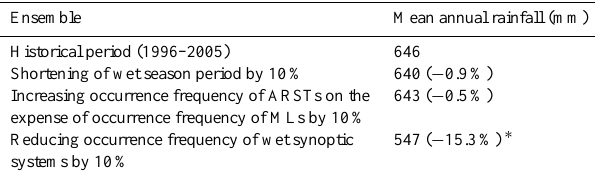
Figure 7. Same as Fig. 6 but for annual streamflow volume for up- per Dalya catchment. Table 4. Summary of the local sensitivity tests. The average annual rainfall of each ensemble and its projected change comparing to the historical ensemble (in parenthesis) are